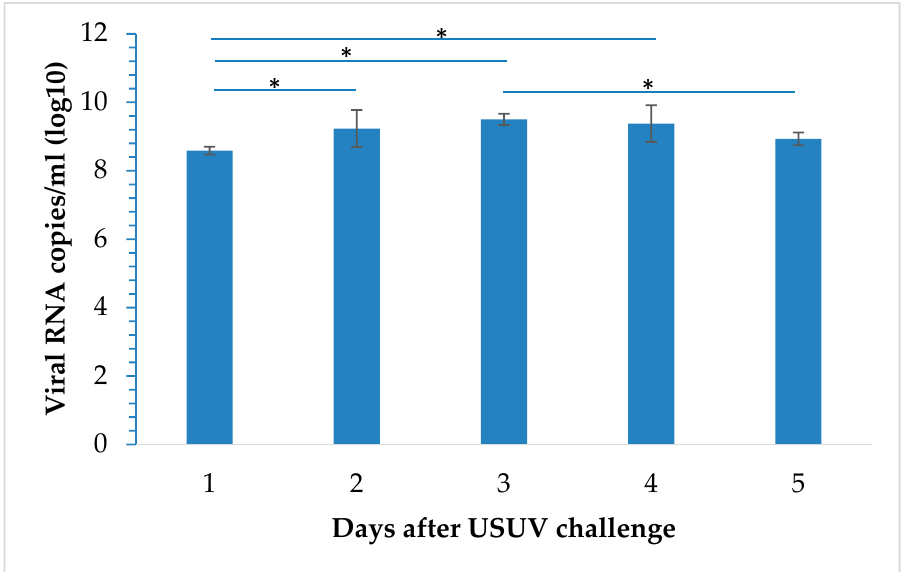
Figure 5. Viral RNA loads in the allantoic fluids from embryonated chicken eggs infected with USU-BE-Seraing/2017 strain at a dose of 10 5 50% tissue culture infective dose (TCID 50 ). Data are representative of five samples per day (error bars represent the standard deviations). n = 5 per day of infection; “*” indicates a p -value < 0.05.